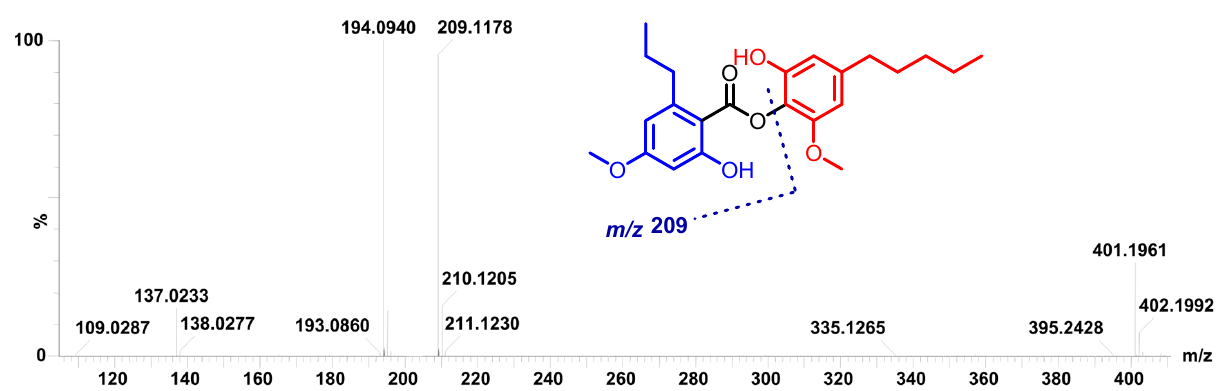
Figure 3. Key COSY and NOESY correlations of compound 5 .